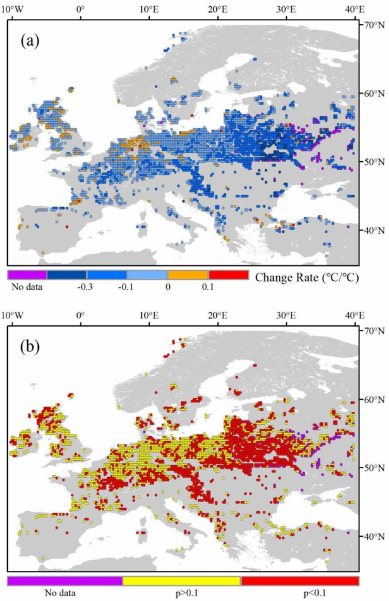
Figure 7. The relationship between background LST and daily LST differences (forest minus open land) during various years. ( a ) The rate of change for daily LST differences under different background LSTs. The number 0.1 indicates that the daily LST difference increases by 0.1 ◦ C when the background LST increases by 1 ◦ C. ( b ) Significance of the relationship between background LST and daily LST differences.